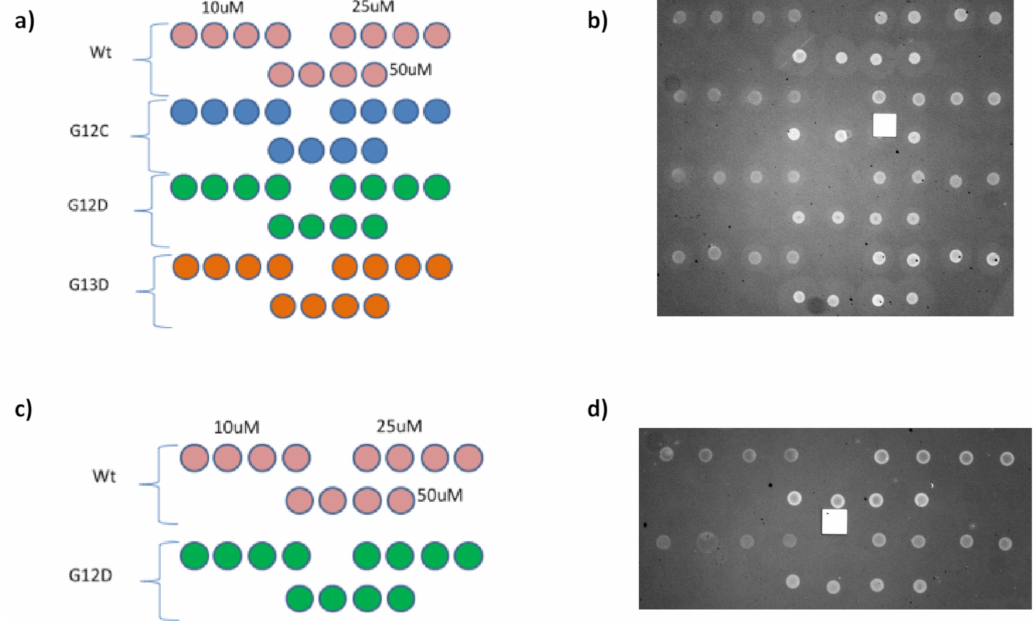
Figure 5. Spotting scheme on ( a ) MCP-4 and ( c ) Copoly Azide 10% coated surfaces and IRIS images of the ( b ) MCP-4 and ( d ) Copoly azide 10% chips, taken immediately after